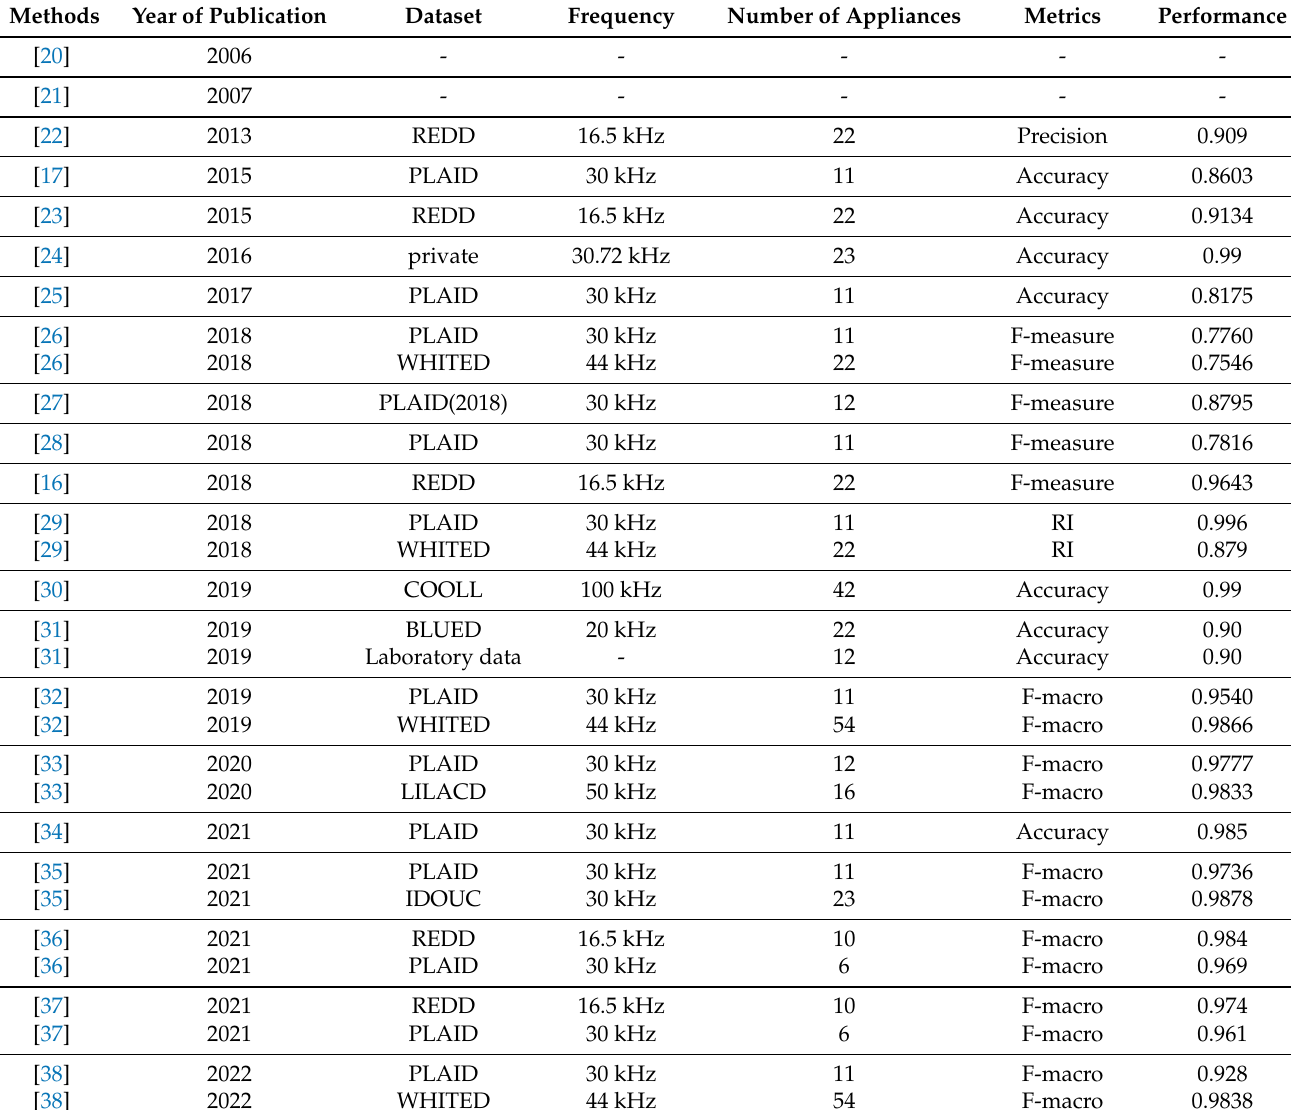
Table 2. Existing methods for load identification based on V-I trajectory